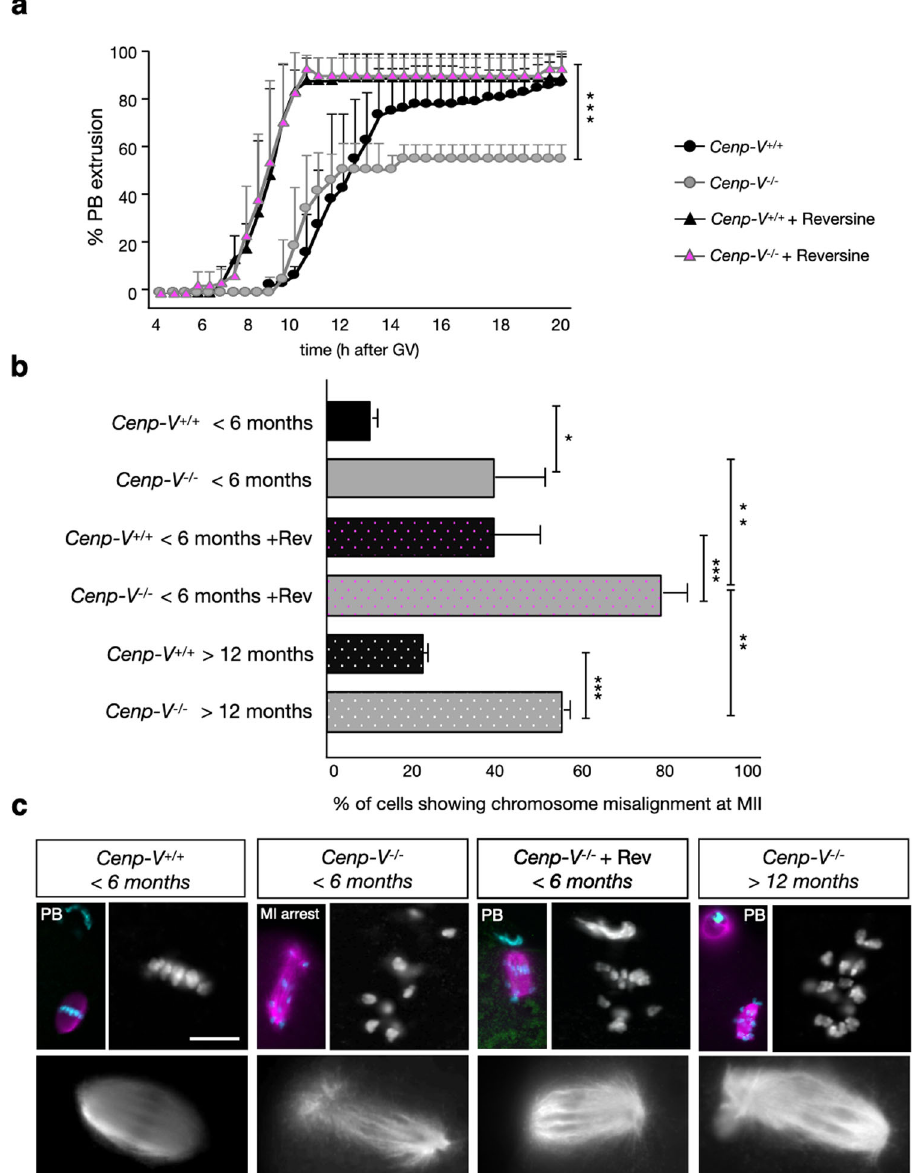
Fig. 4 Inhibition of MPS I or ageing allow Cenp-V − / − oocytes to proceed to anaphase I. a Cumulative percentage of fi rst polar body extrusion (PBE) over time in Cenp-V + / + and Cenp-V − / − oocytes treated with reversine. Note that the addition of reversine restores PBE to control values. The addition of reversine accelerates and increases PBE in both Cenp-V + / + and Cenp-V − / − oocytes. b Percentage of cells that harbour misaligned chromosomes at MII in young oocytes treated with reversine and in old cells. Reversine increases the misalignment also in control cells compared to non-treated cells. 4a: statistical differences refer to the average of all data points. Statistic: ( a , b ) data were expressed as mean ± SD and statistical differences were tested by a two way Anova test (*** p < 0.001, ** p < 0.01, * p < 0.05). The exact p values are available in the source data fi le. Statistical differences refer to the average of all data points. Cenp-V + / + and Cenp-V − / − oocytes treated with reversine show not a signi fi cant difference. ( a ) n = 112 oocytes from 3 independent experiments and ( b ) n = 10 cells per condition from 4 independent experiments. c Example of Cenp-V + / + and Cenp-V − / − oocytes treated with reversine in young females and one example of Cenp-V − / − oocyte >12 months for comparison. Note that the absence of CENP-V in young females arrests half of the cells in MI and only after the addition of reversine all oocytes proceed to anaphase and extrude the PB. Microtubules are stained by anti-ß-tubulin (magenta), centromeres are stained with anti ACA (green) and DNA is stained by Hoechst 33258 (cyan). Enlarged images in grey shown the single channel of the chromosomes and spindle. Scale bar = 10 µ